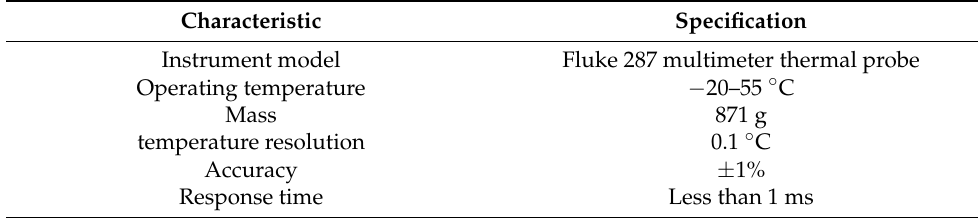
Table 3. Technical data of Fluke 287 multimeter thermal